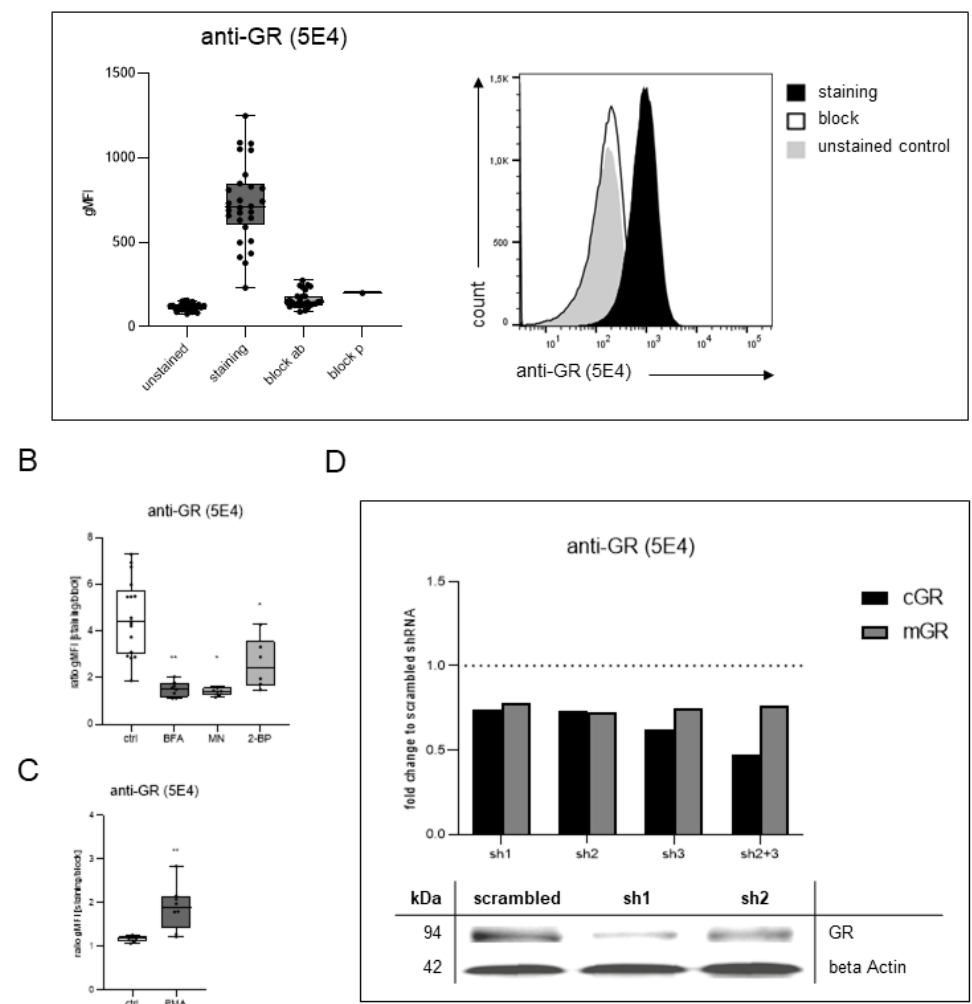
Figure 1. Anti-GR (5E4) antibody surface staining. ( A ) HEK293 cells were analyzed for mGR expression by flow cytometry using the anti-GR (5E4) antibody (n = 28). The staining was blocked successfully by 10-min incubation with 100-fold excess unconjugated primary antibody (block ab) or APTEK-26 peptide (block p) prior to the staining procedure. The gating strategy is displayed in Supplementary Figure S1A. Staining intensities are depicted as geometric mean fluorescence intensity (gMFI). ( B ) mGR expression on HEK293 cells after inhibition of Golgi transport and protein palmitoylation. Cells were incubated with 1 µ g/mL BFA, 0.5 µ g/mL MN, and 100 µ g/mL 2-BP, respectively, for 24 h and mGR expression was measured by flow cytometry using the anti-GR